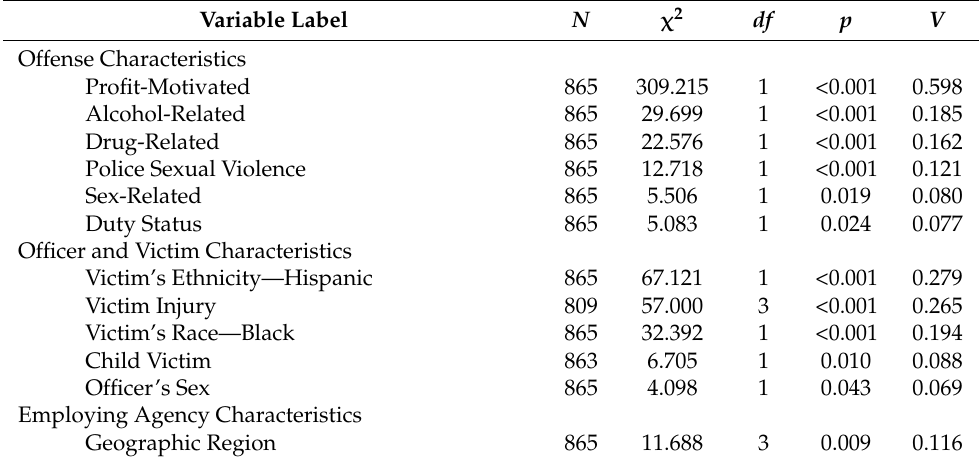
Table 4. Violence-related bivariate